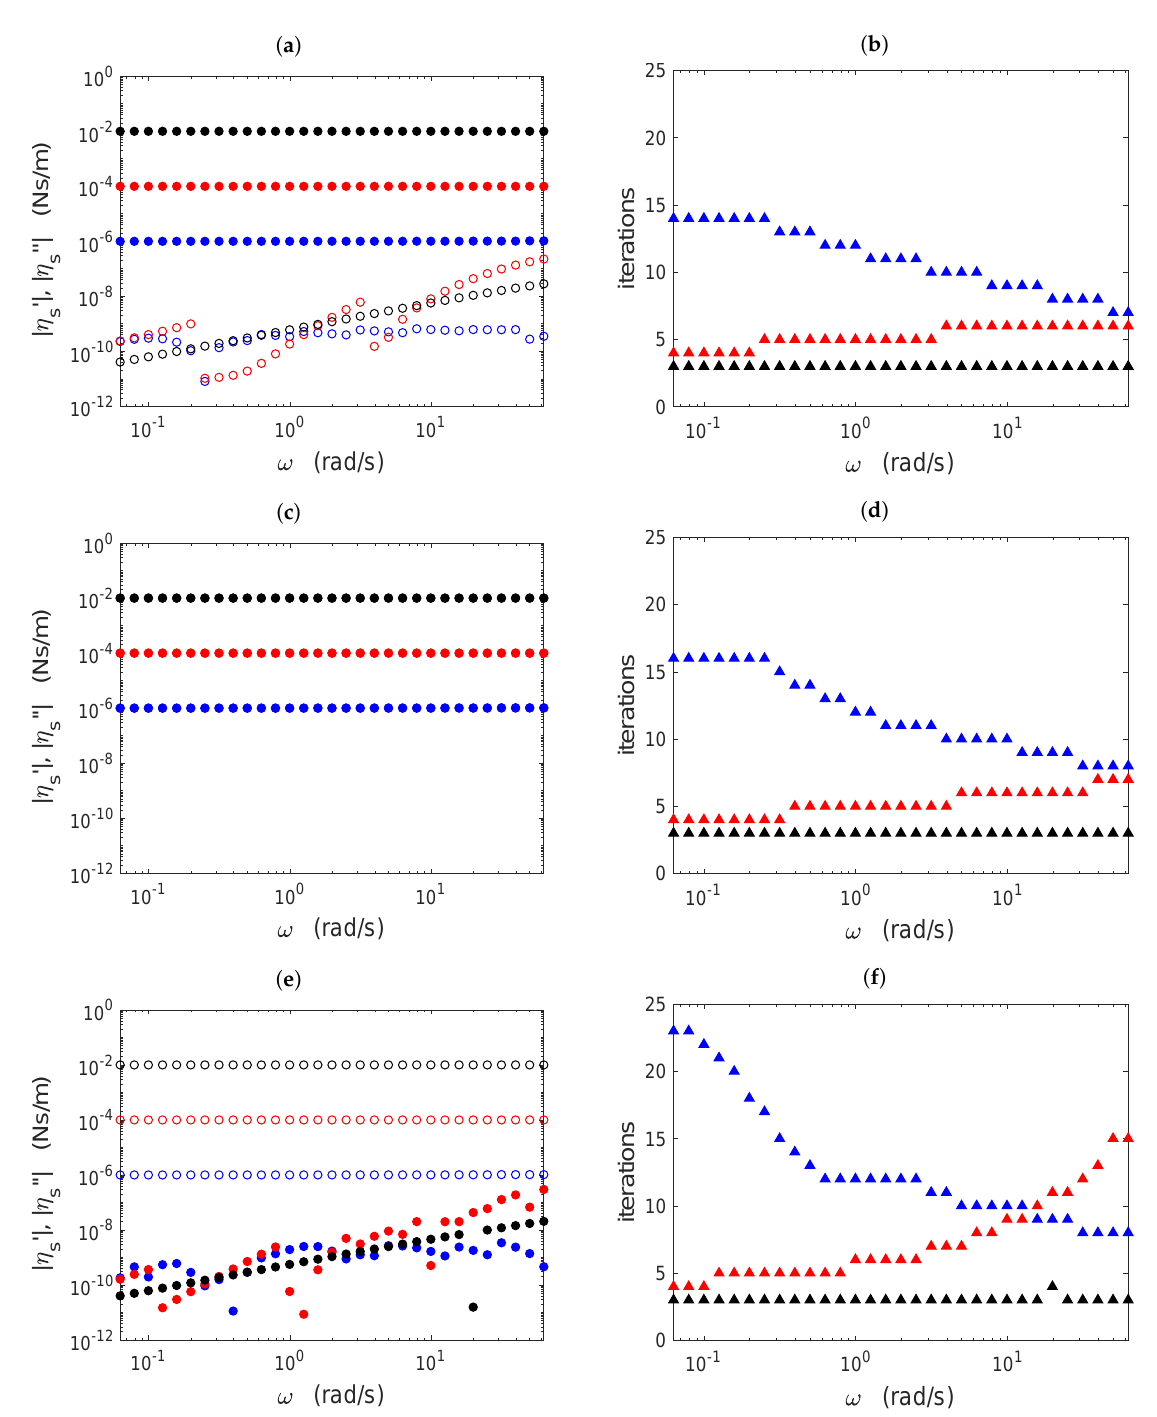
Figure 3. Values obtained for the complex interfacial viscosity (left column, ( a , c , e )) and number of iterations needed for convergence (right column, ( b , d , f )) as a function of frequency for purely-viscous interfaces (top row, ( a , b )), viscoelastic interfaces (middle row, ( c , d )), and purely-elastic interfaces (lower row, ( e , f )). In the graphs in the left column, filled and empty circles refer to the real and imaginary parts of the complex interfacial viscosity, respectively. Symbols’ colors indicate the numerical value of η s , namely η s = 10 − 2 (black), η s = 10 − 4 (red), and η s = 10 − 6 (blue), in units of N